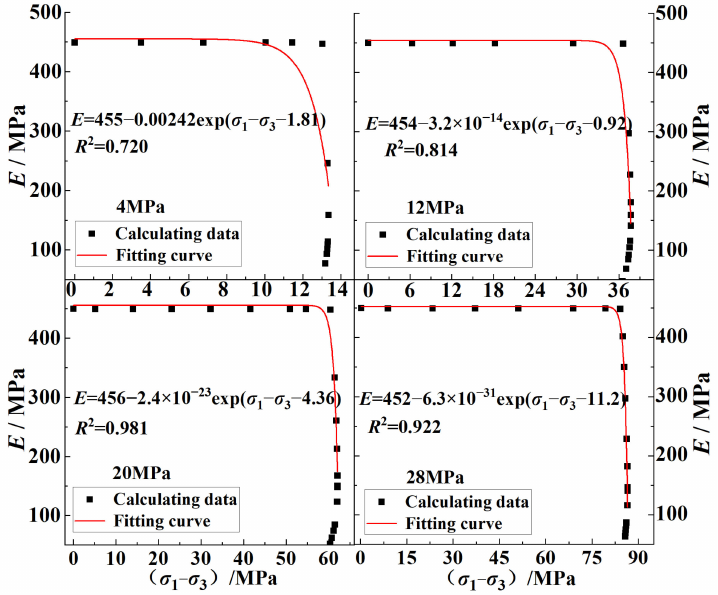
Figure 13. Fitting curves of deformation modulus with stress difference under different confining pressures.